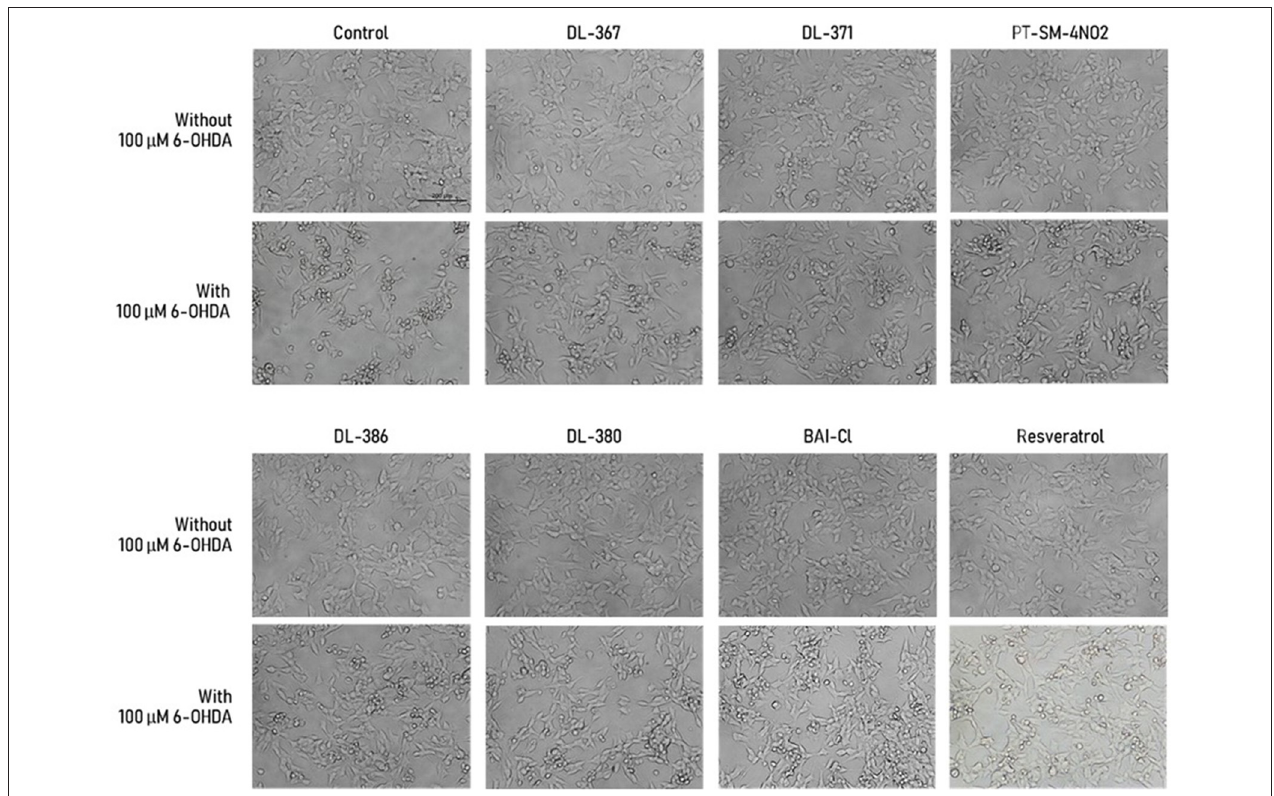
FIGURE 3 | Morphological alteration of SH-SY5Y cells was observed under the inverted-light microscope at 20 × magnification. Scale bar = 200 µ